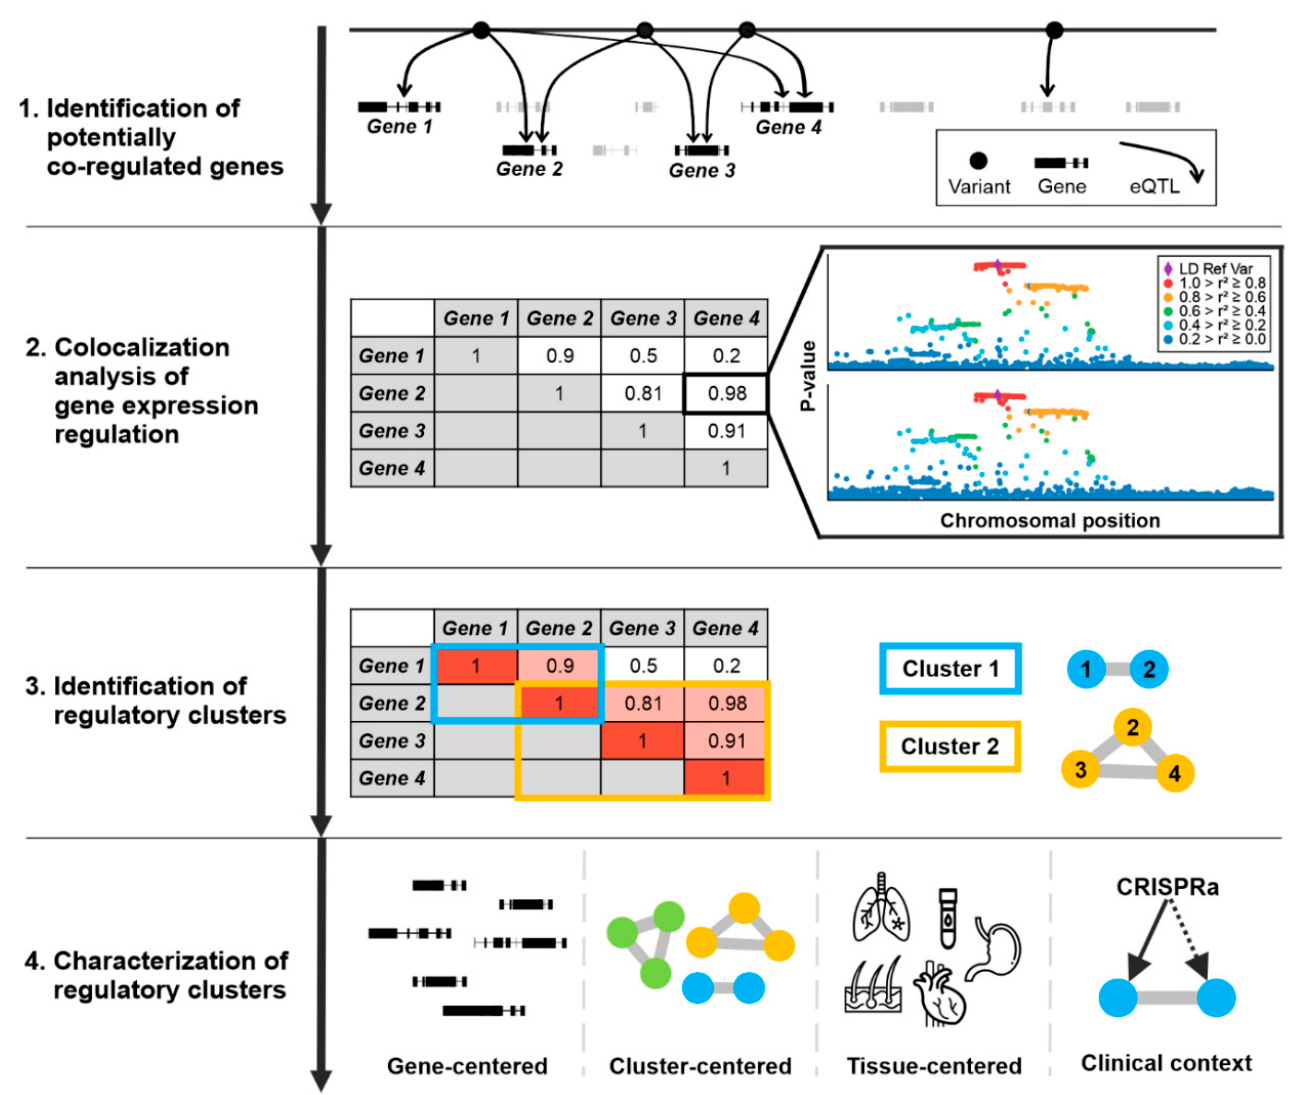
Figure 1. Schematic workflow of the gene expression regulation cluster analysis. Clusters of co-regulated gene expression were defined as genomic regions containing multiple genes regulated by the same eQTL signal. In a first step, the eQTL results were filtered for eVariants regulating at least two eGenes. The corresponding eQTL signals were then analyzed for colocalization (Step 2). Gene pairs with a colocalization probability of 0.80 and higher were considered to be co-regulated. Next, eGenes with colocalizing eQTL signals were grouped in regulatory clusters (Step 3). These clusters were subsequently investigated on multiple levels considering a gene-centered, a cluster-centered, and a tissue-centered perspective to enable a comprehensive interpretation of results. Finally, genes with clinical relevance to haploinsufficiency-related disease were investigated for their involvement in gene expression regulation clusters and the impact of potential therapeutic approaches. For example, the CRISPRa technology [9] could affect gene expression of the targeted gene but also of off-target genes within the same